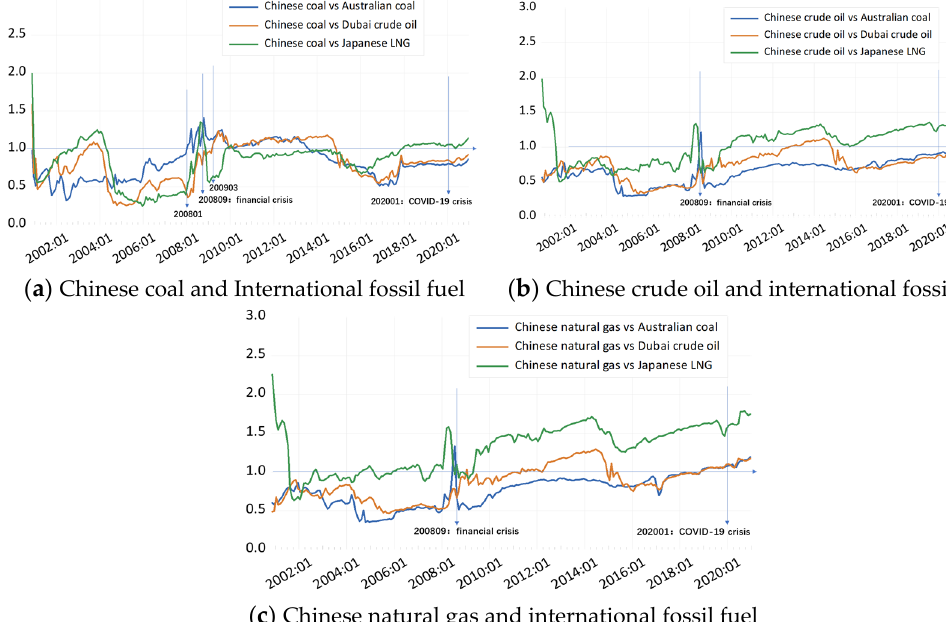
Figure 2. Recursive cointegration of Chinese and International fossil fuel prices.